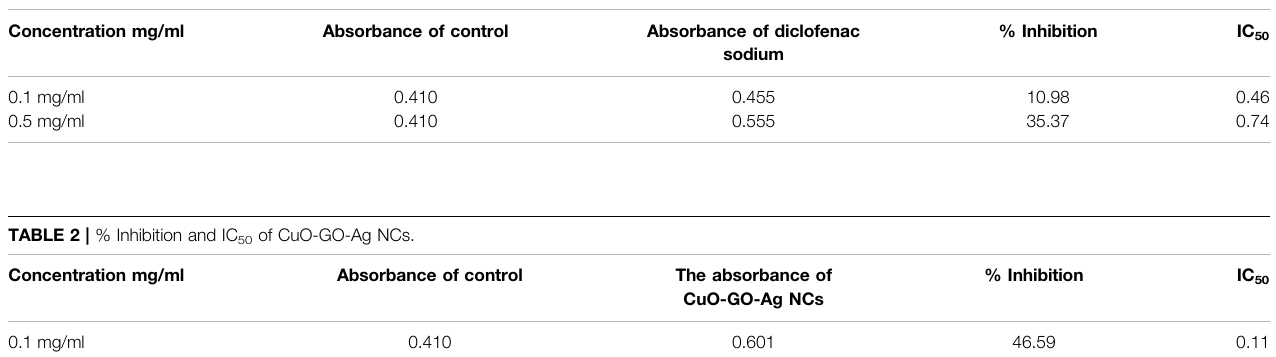
TABLE 1 | % Inhibition and IC 50 of standard (diclofenac sodium).